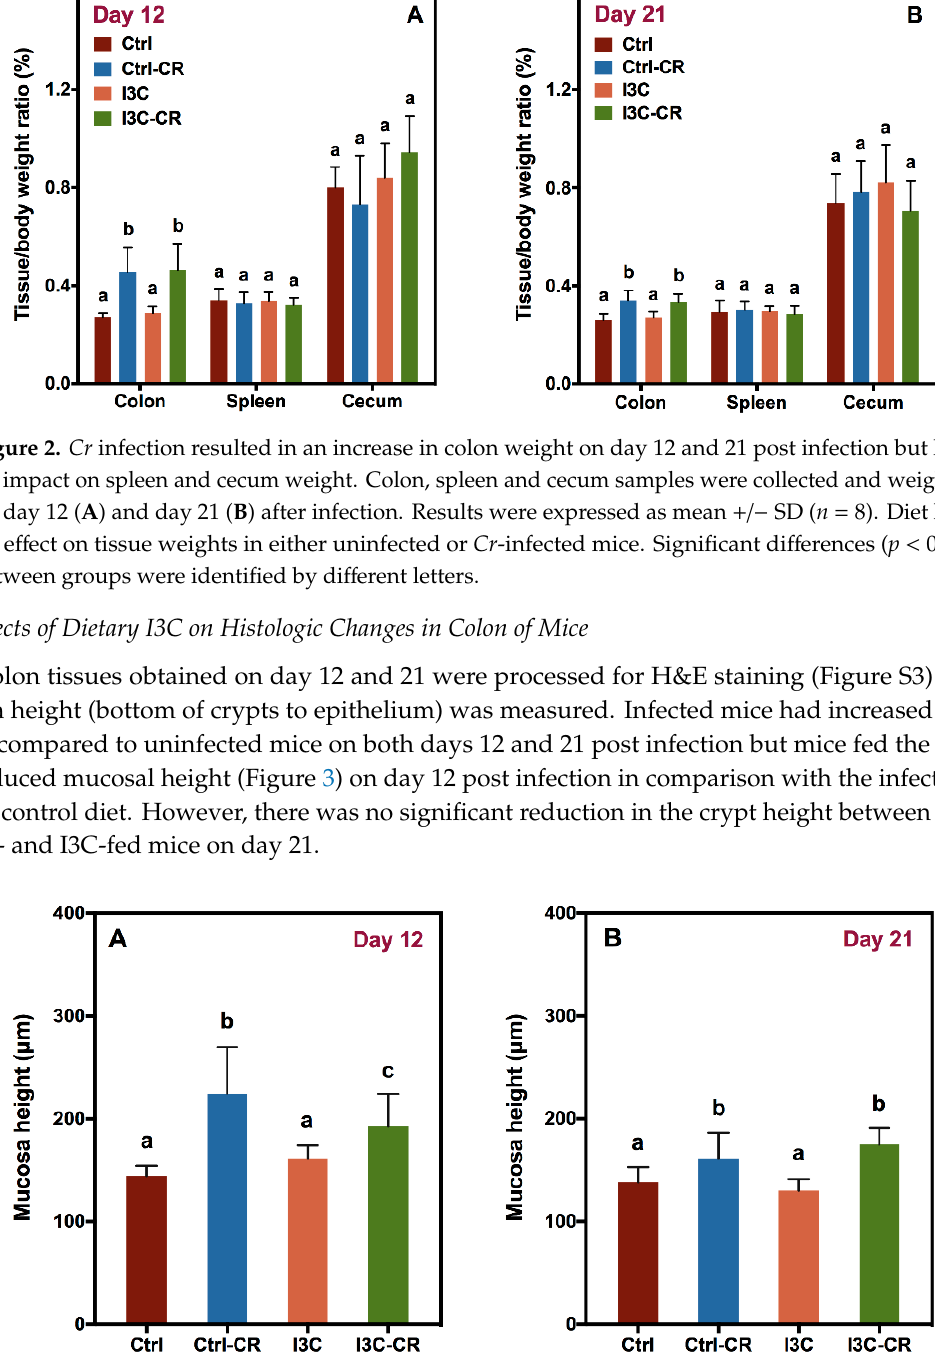
Figure 3. I3C reduces colonic hyperplasia at day 12 but not day 21 post infection. Colon tissue was collected on day 12 ( A ) and day 21 ( B ) after infection and processed for H&E staining. Mucosa height was measured on well-oriented crypts and 12 or more individual measurements were averaged for each mouse. Results were expressed as mean +/- SD ( n = 8). Significant differences ( p < 0.05) between groups are identified by different letters.